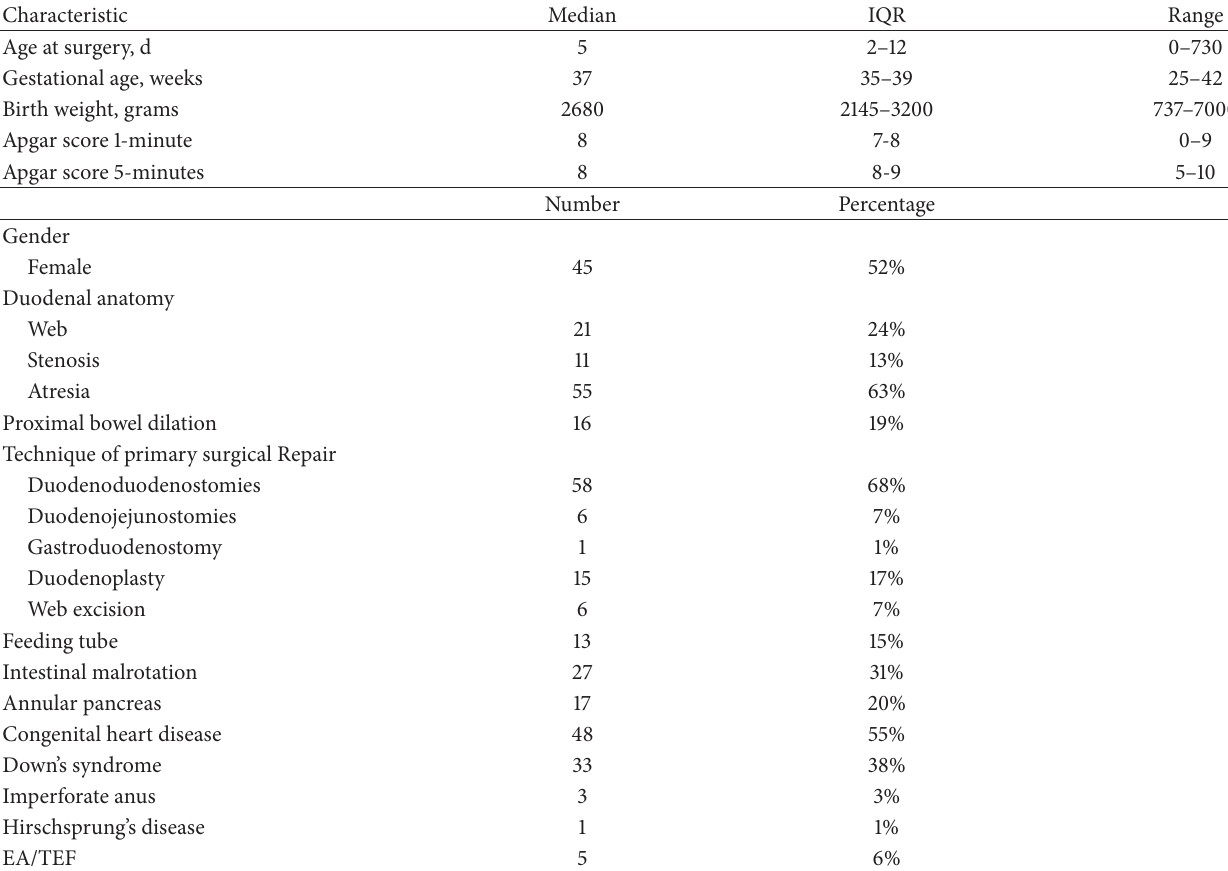
Table 1: Patients’ characteristics with duodenal obstruction ( 𝑁 = 87